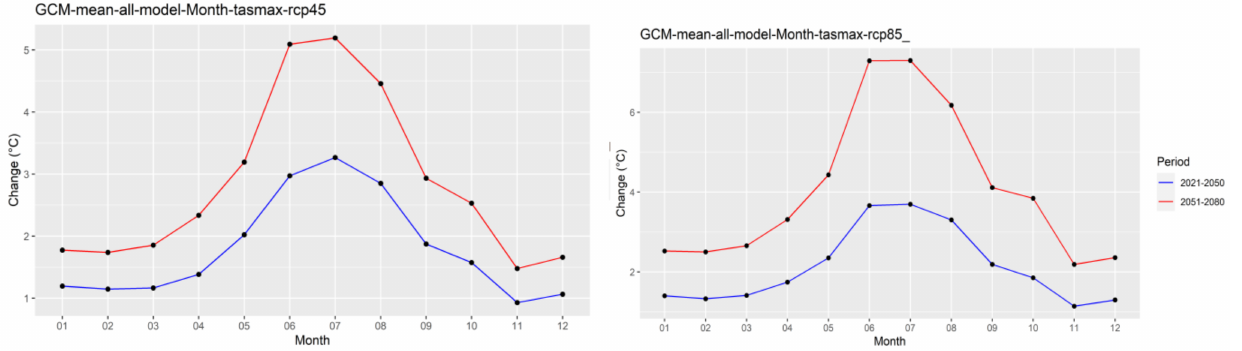
Figure 26. Average monthly temperature change (minimum) under RCP4.5 and RCP8.5 scenarios for the Devil’s Creek, 2021–2050 and 2051–2080 periods. The multi-model ensemble average of 15 GCMs.